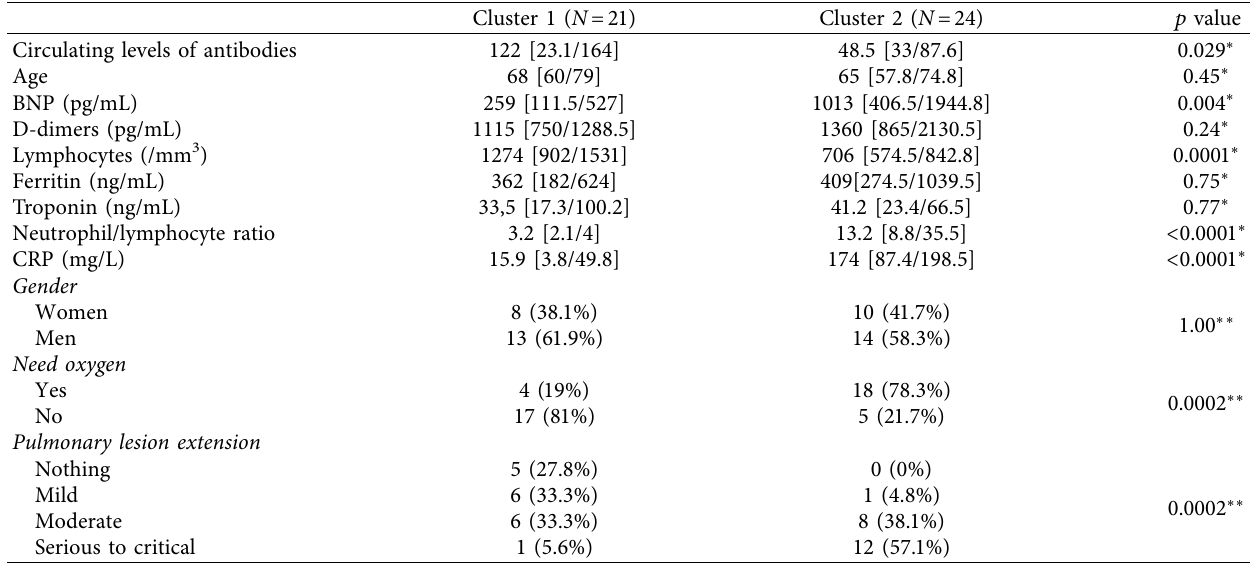
Table 2: Comparison of categorial and continuous variables between cluster 1 and cluster 2 characterized by statistical differences in circulating levels of SARS-CoV-2 antibodies.